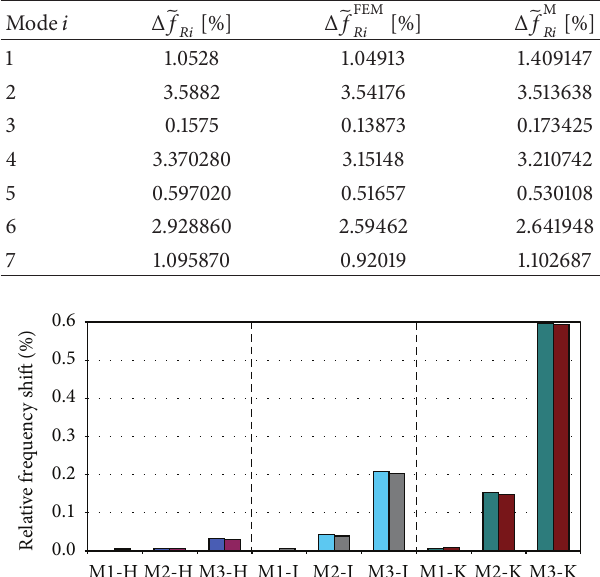
Table 8: The relative frequency shifts for the regions affected by concentrated loads.